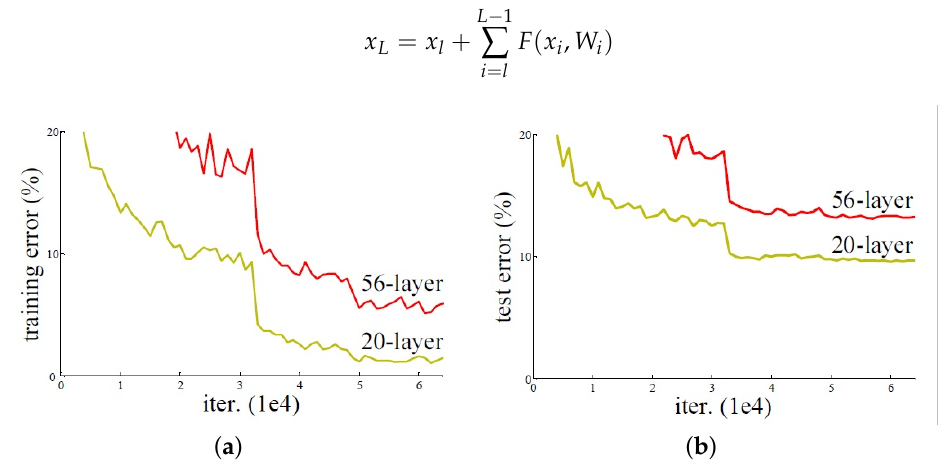
Figure 5. Comparison of CNN training results and standard calibration errors [31]: ( a ) training set error graph; ( b ) checkset error graph.